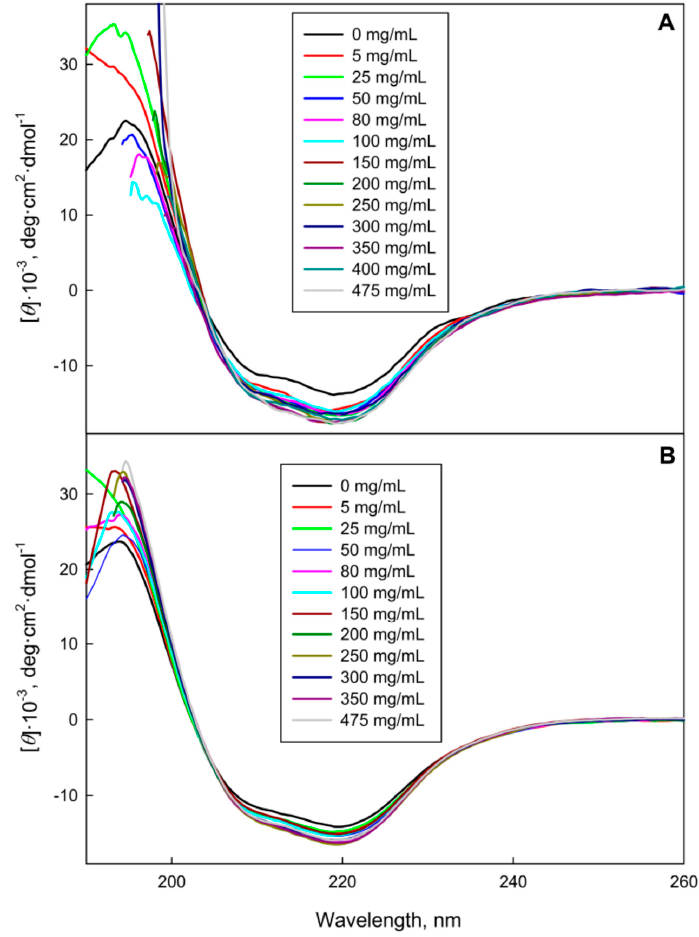
Figure 3. Far-UV CD spectra of GGBP in the presence of Ficoll-70 ( A ) and Dextran-70 ( B ).